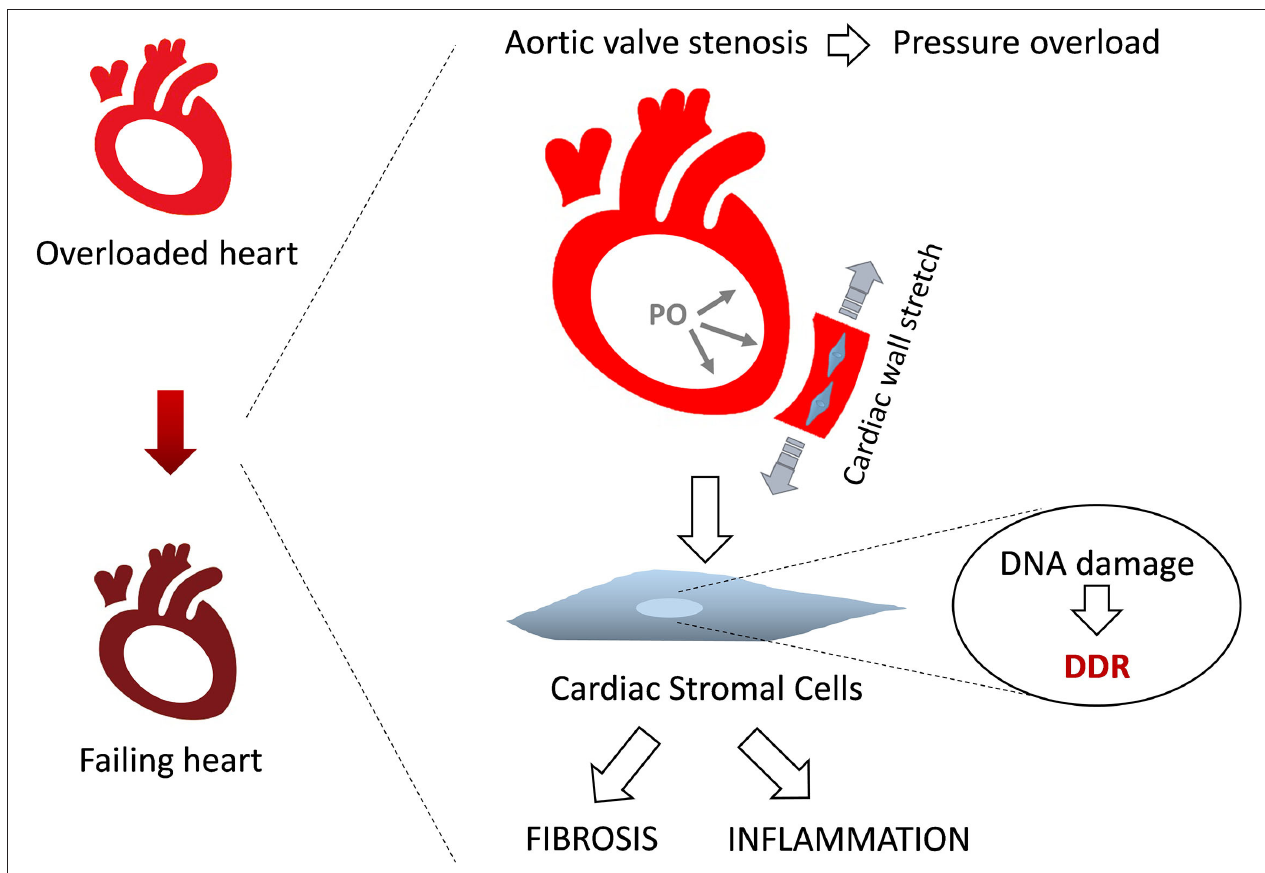
FIGURE 6 | Study rationale and conclusions. Aortic valve stenosis induces cardiac pressure overload. This leads to non physiological deformation of the ventricle wall, causing DNA damage and persistent DDR activation. In turn, this promotes C-MSC pro-fibrotic and pro-inflammatory fate, contributing to heart failure